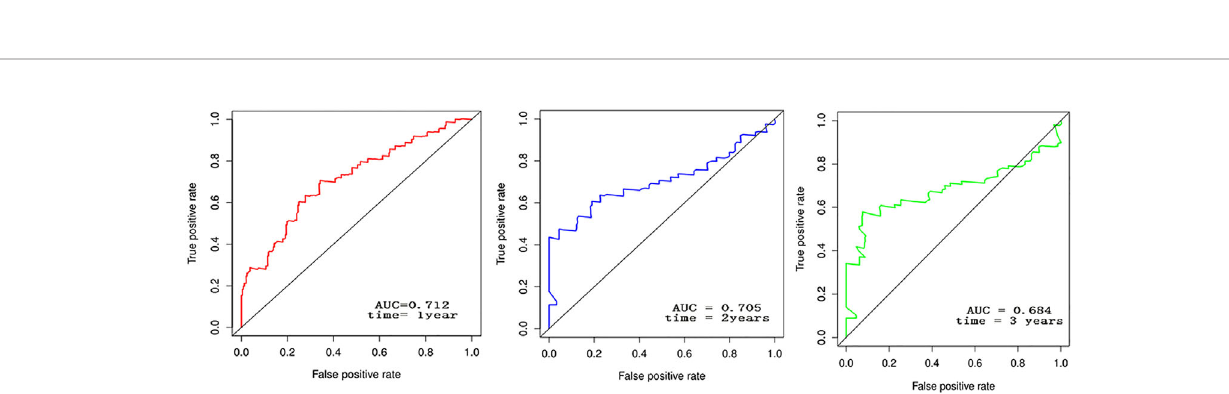
FIGURE 7 | The prognostic values of CXCR signature. (A) The survival curves of low- and high- risk group. (B) The heatmap of gene signature. (C) The risk score of AML patients in two groups.